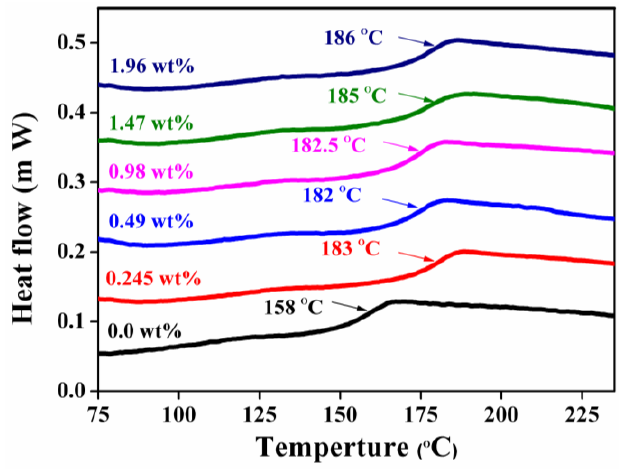
Figure 8. DSC curves of epoxy/GPLP composites.